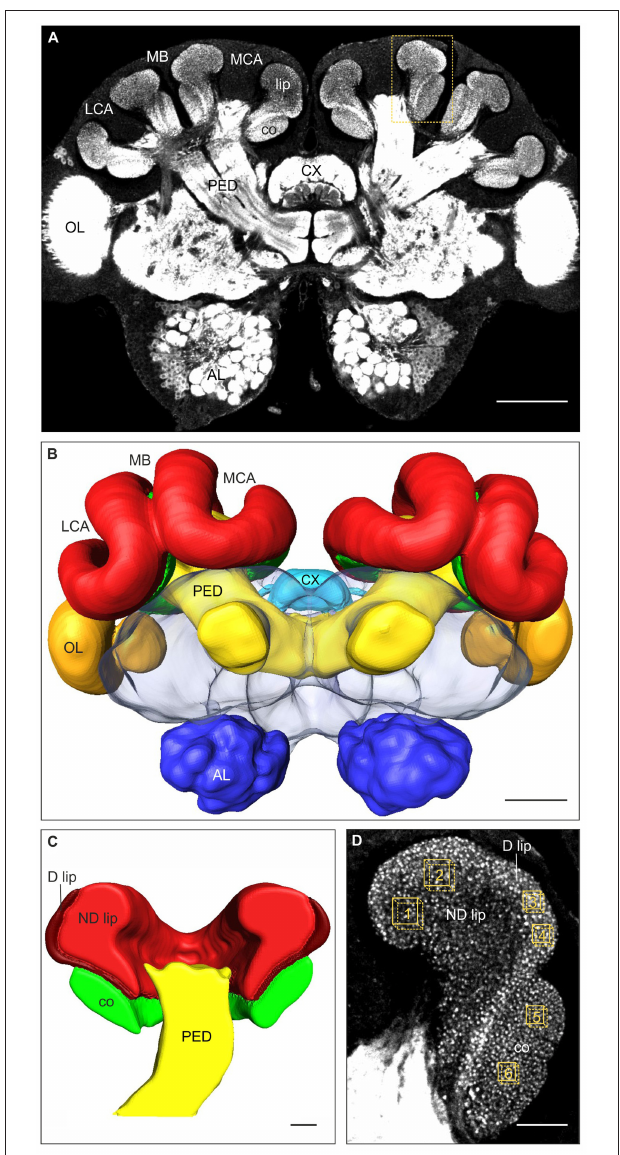
FIGURE 1 | Immunofluorescence staining with anti-synapsin antibody, 3D reconstruction, and MG quantification in brains of 2-day old C. mus workers. (A) Frontal overview of a brain in a central plane. Higher magnification of the area marked by the box is shown in (D) . (B) 3D reconstruction of the brain showing the major neuropils. (C) Frontal plane of the 3D reconstruction of the MB calyx showing the visual collar, and the dense (D) and non-dense (ND) olfactory lip subregions. (D) Higher magnification of the medial MB calyx (box shown in A ). Boxes 1–2, 3–4, and 5–6 indicate the volumes used for quantification of the presynaptic boutons in the ND lip, D lip and collar regions of the MB calyces, respectively. AL, antennal lobe; co, collar; CX, central complex; LCA, lateral calyx; MB, mushroom bodies; MCA, medial calyx; OL, optic lobe; PED, pedunculus. Scale bars: (A,B) 100 µ m; (C,D) 20 µ